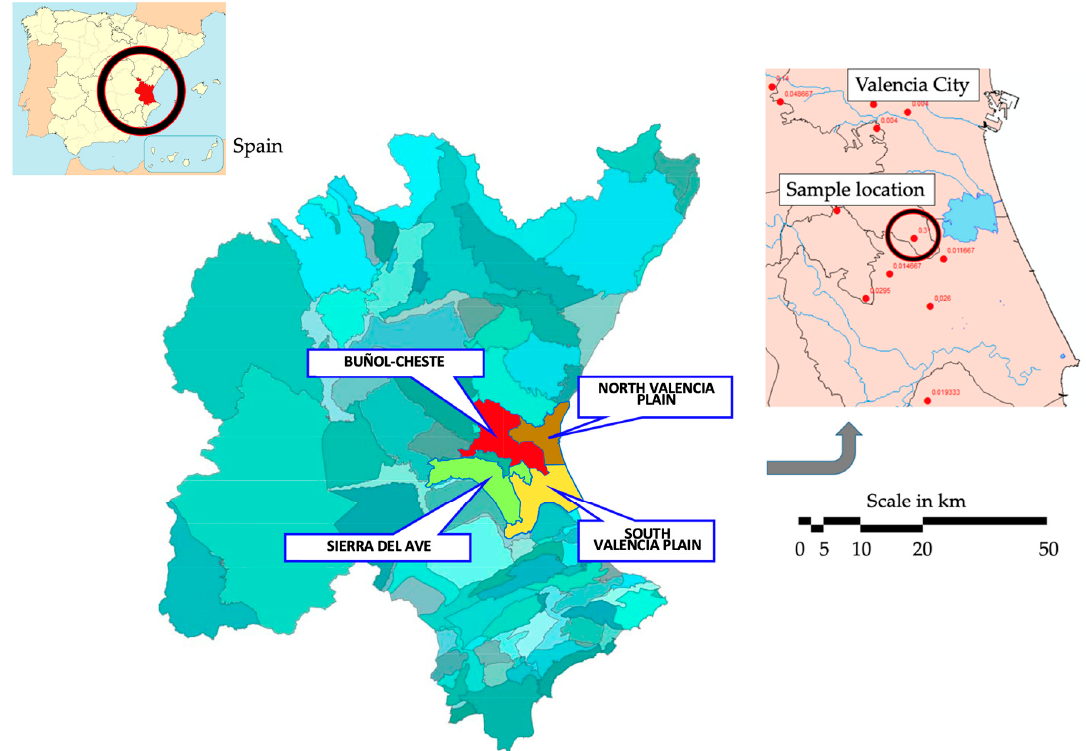
Figure 1. Location of the South Valencia Plain aquifer and the sample location.